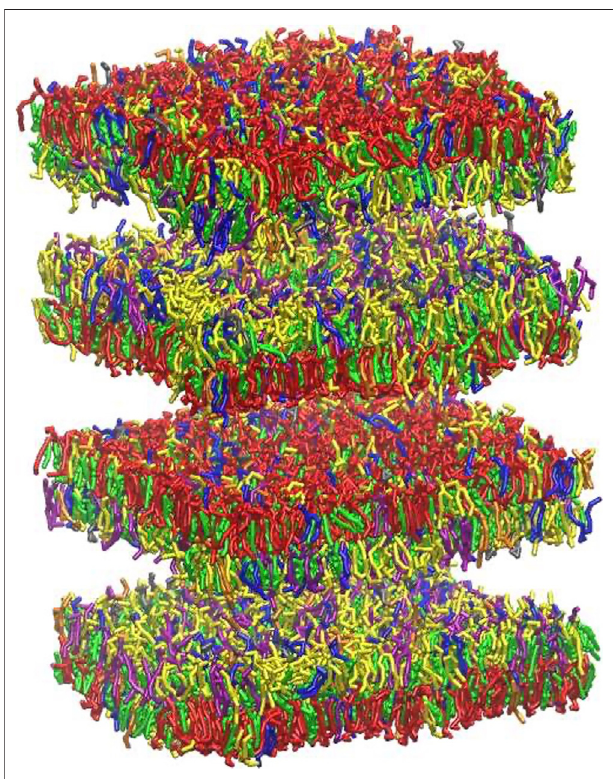
FIGURE 6 | Graphical representation of multi-layer myelin at 25 μ s. The multi-bilayers system was built using a distance of around 1.7 nm between extracellular and cytoplasmic layers. For lipid molecules color code see Figure 2 and for bilayer composition see Table 2